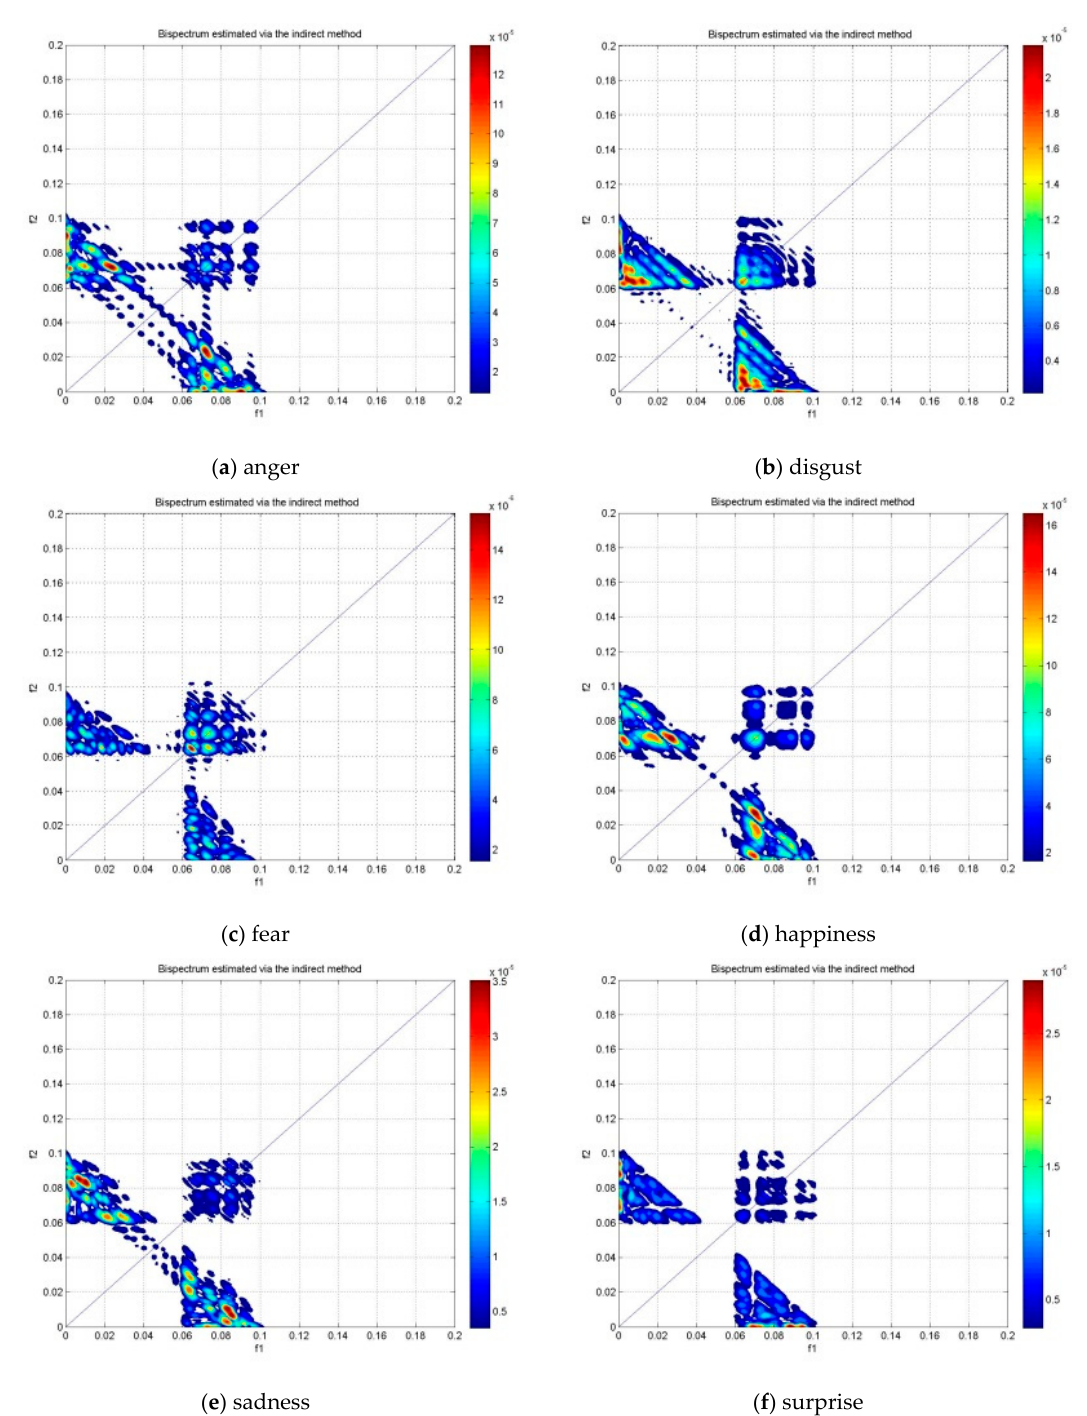
Figure 7. The bispectrum contour plot of the non-redundant region and one symmetry region in the alpha band of subject #1 RBD group. Table 2. Statistical validation results of LBD, RBD, and NC by using ANOVA (statistically significant at p ≤ 0.05).